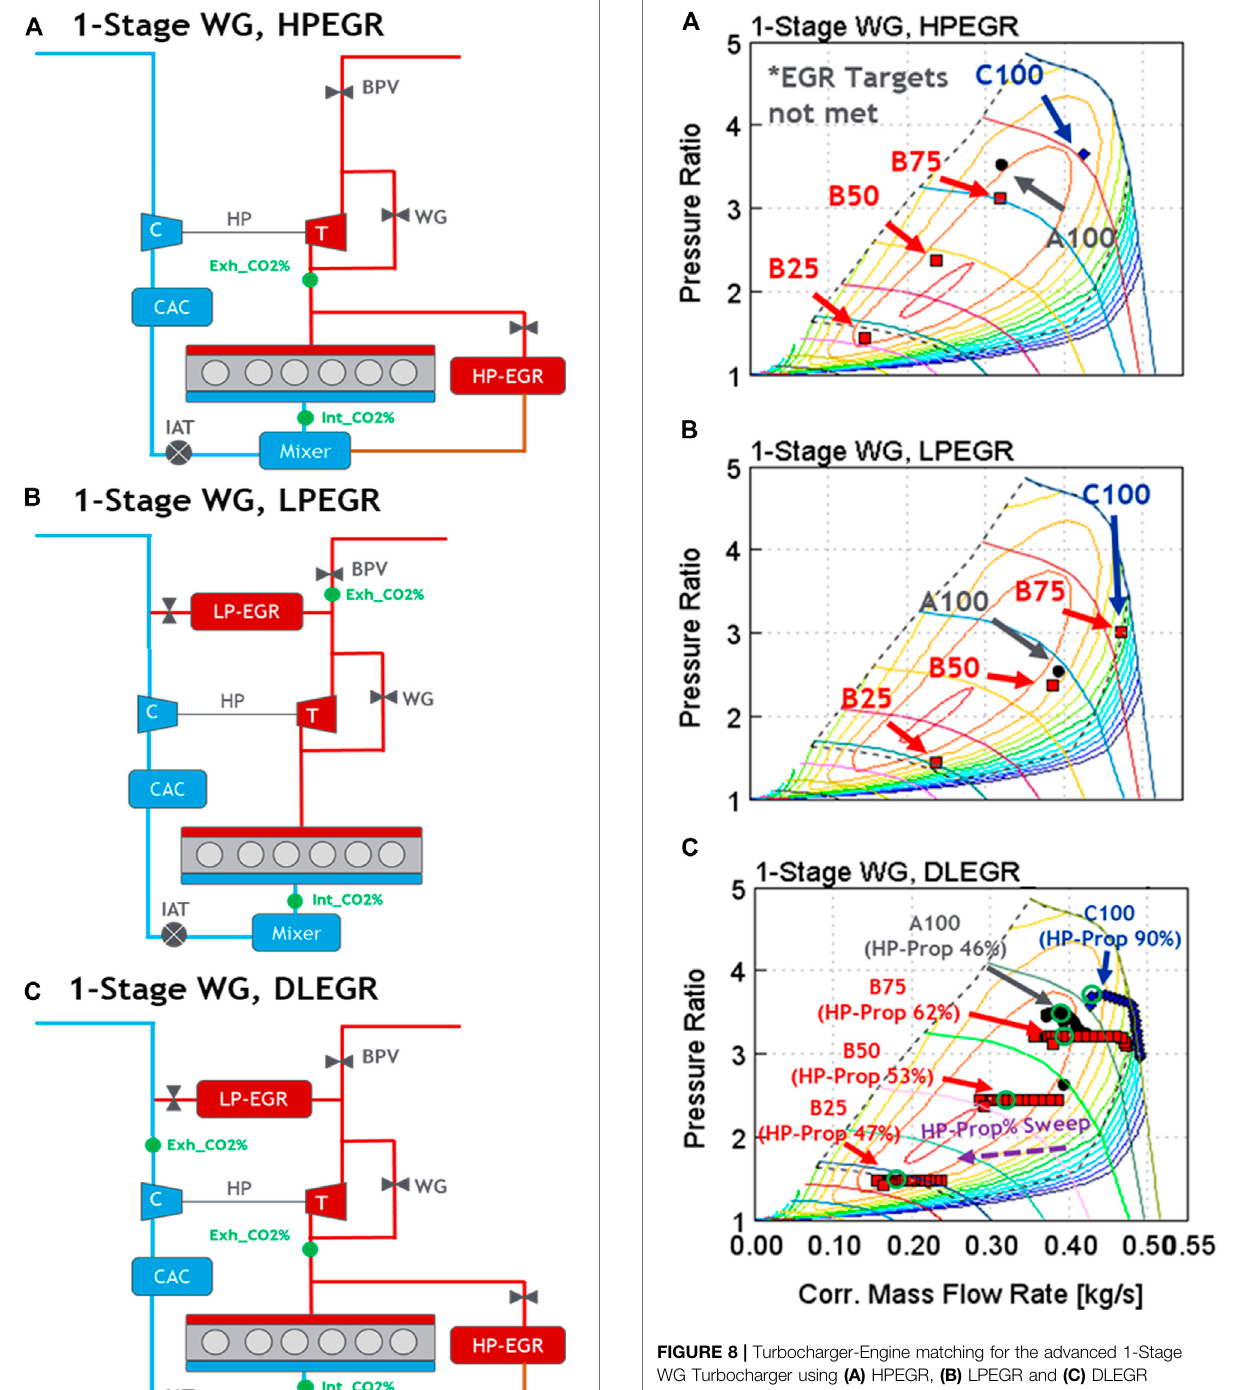
conducted at each operating condition. Figure 8C shows compressor matching performance with respect to the high- pressure HP-Prop% sweep across the fi ve operating points.